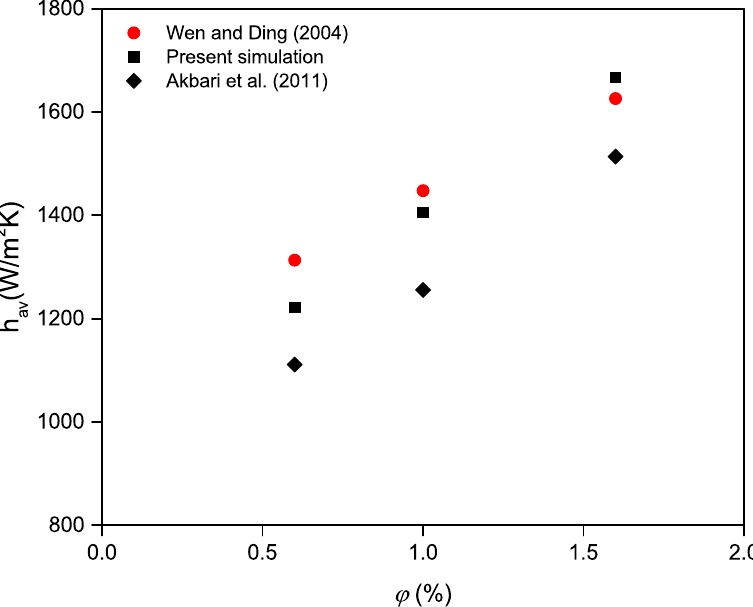
Figure 4. Influence of the concentration of Al 2 O 3 nanoparticles ϕ on the average heat transfer coefficient for Re = 1600 and d np = 42 nm. Comparisons with the experimental data of Wen and Ding [11] and the numerical simulations of Akbari et al.